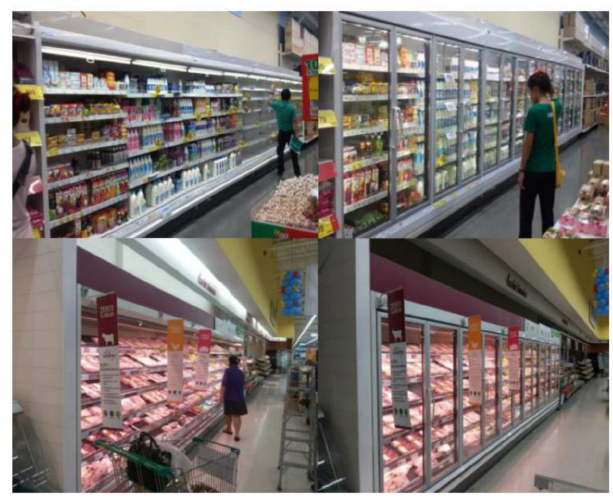
Figure 3. Installation of low-E glass door for store No.2